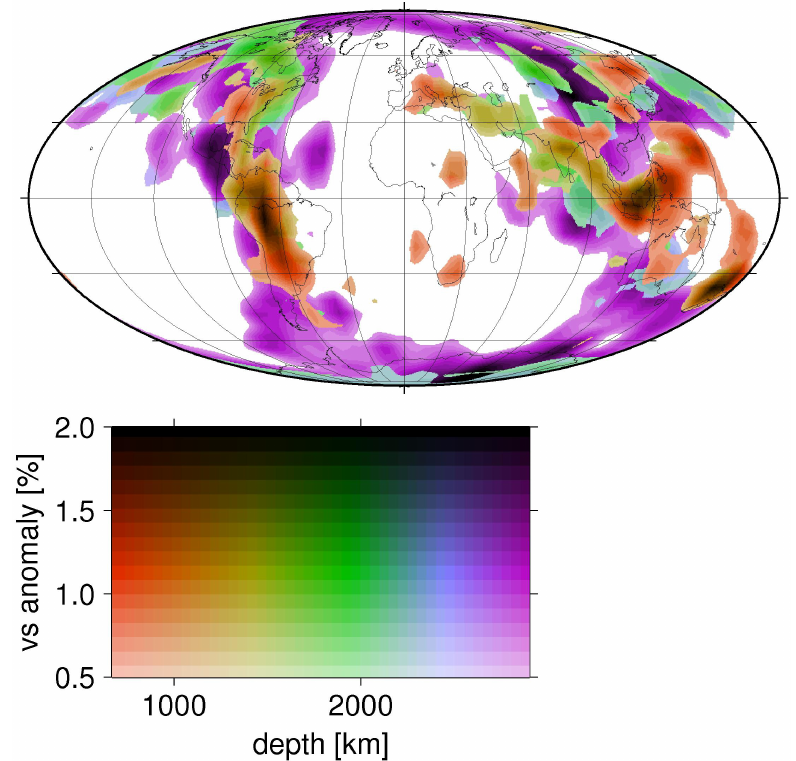
Fig. 3. A representation of the SMEAN (Becker and Boschi, 2002) composite tomography model that is meant to show the depth and intensity of slab-related anomalies. For each location, we determine local maxima of the S -wavespeed anomaly vs. depth profile, as such maxima may correspond to the centers of subducted slabs. We plot the depth (represented by color) and S -wavespeed anomaly (represented by darkness) of such maxima, if they occur in the lower mantle (depth > 670km) and exceed 0.5%. If at a given location more than one maximum satisfying these conditions is found, only the upper one or uppermost one is plotted, corresponding to a “view from